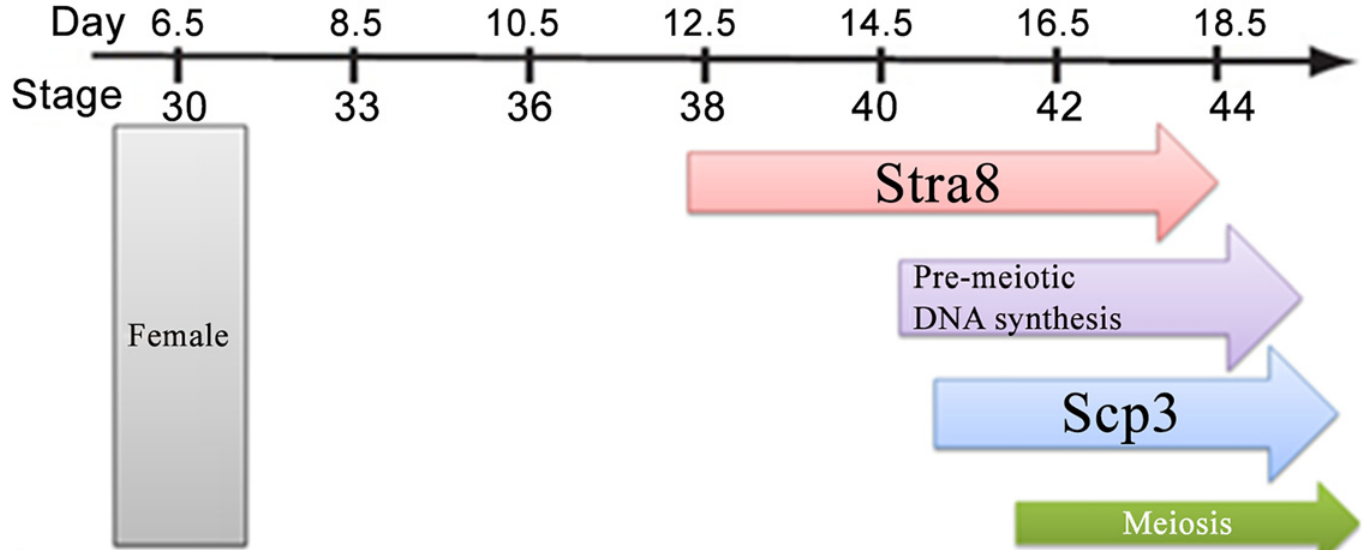
Fig 1. Schedule of meiosis-related marker genes during chicken ovarian